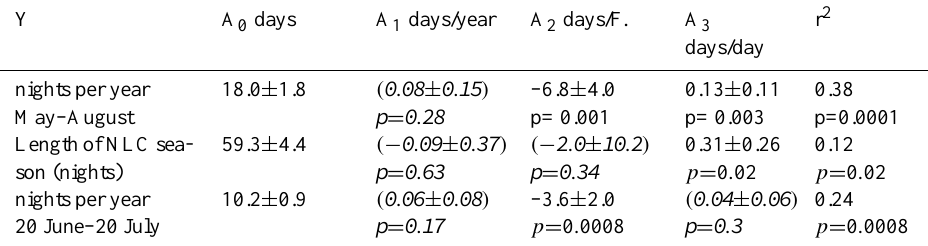
Table 2. Results of multi-parameter linear fits to the NLC statistics, excluding nights when only faint or very faint NLC were reported. The fits are to the